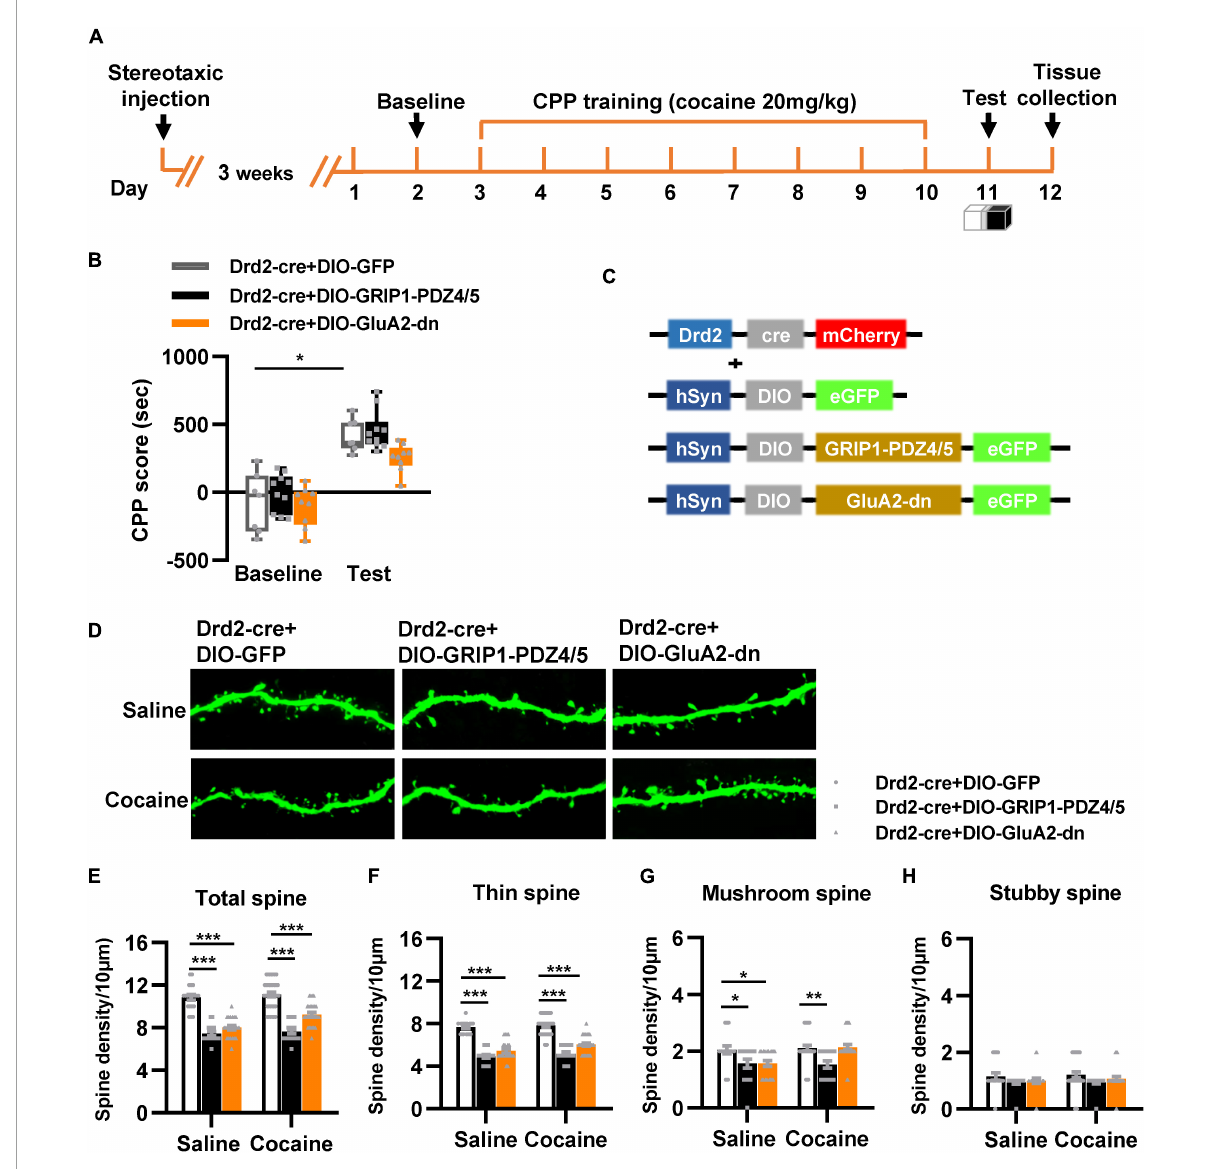
FIGURE4 Interference with GRIP1 and GluA2 interaction in D2-MSNs blocks cocaine acquisition and decreases spine density of D2-MSNs. (A) Experimental design for the behavioral tests and spine analysis. Three-compartment biased CPP models were used. (B) GluA2-dn expressed in D2-MSNs blocked cocaine-induced place preference; GRIP1-PDZ4/5 expressed in D2-MSNs did not affect cocaine-induced place preference. (C) Viral vectors used to interfere with the interaction of GRIP1 and GluA2 in D1-MSNs. (D) Representative images of GFP-labeled dendrites. (E–H) The statistical data for total spine, thin spine, mushroom spine, and stubby spine density. n = 20–30 dendrites obtained from 8–10 mice per group. * P < 0.05, ** P < 0.01, and *** P < 0.001.